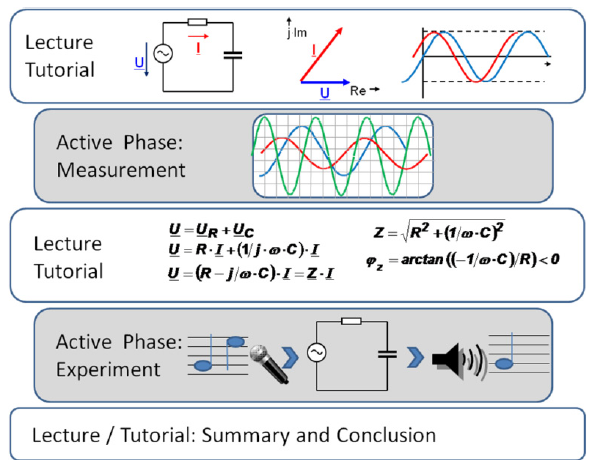
Figure 2. Implementation of the Sandwich-Principle